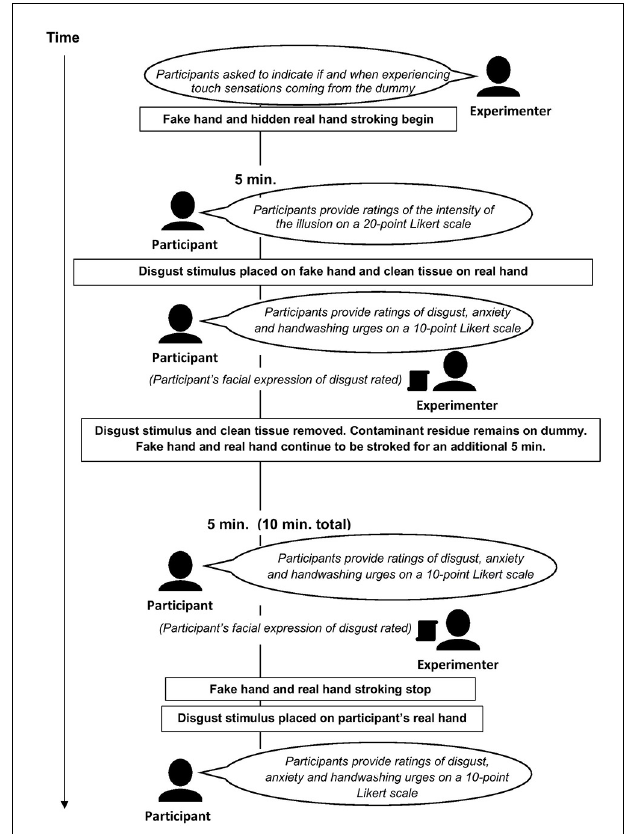
FIGURE 3 | Overview of